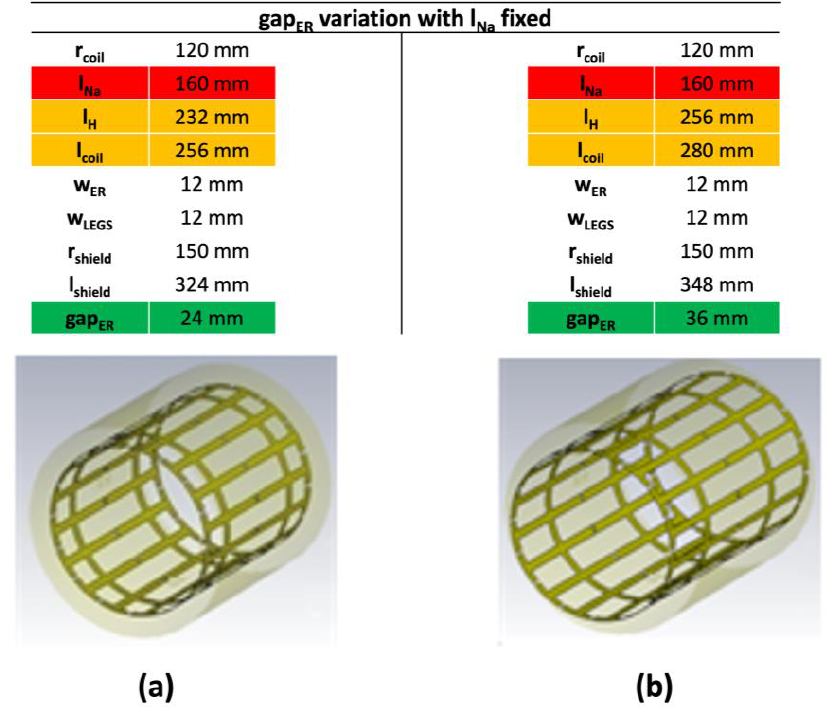
Figure 3 . EM CAD model of the four-ring DT-RF coil model versus the geometrical dimensions. The gap ER variable parameter is in green, while the parameters changing with the gap ER parameter are in orange. In red are the fixed parameters.